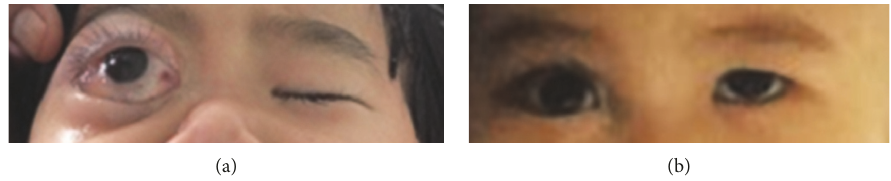
Figure 1: (a) Photograph demonstrating proptosis of the right eye. (b) After 4 weeks of induction chemotherapy, decrease in the size of proptosis.